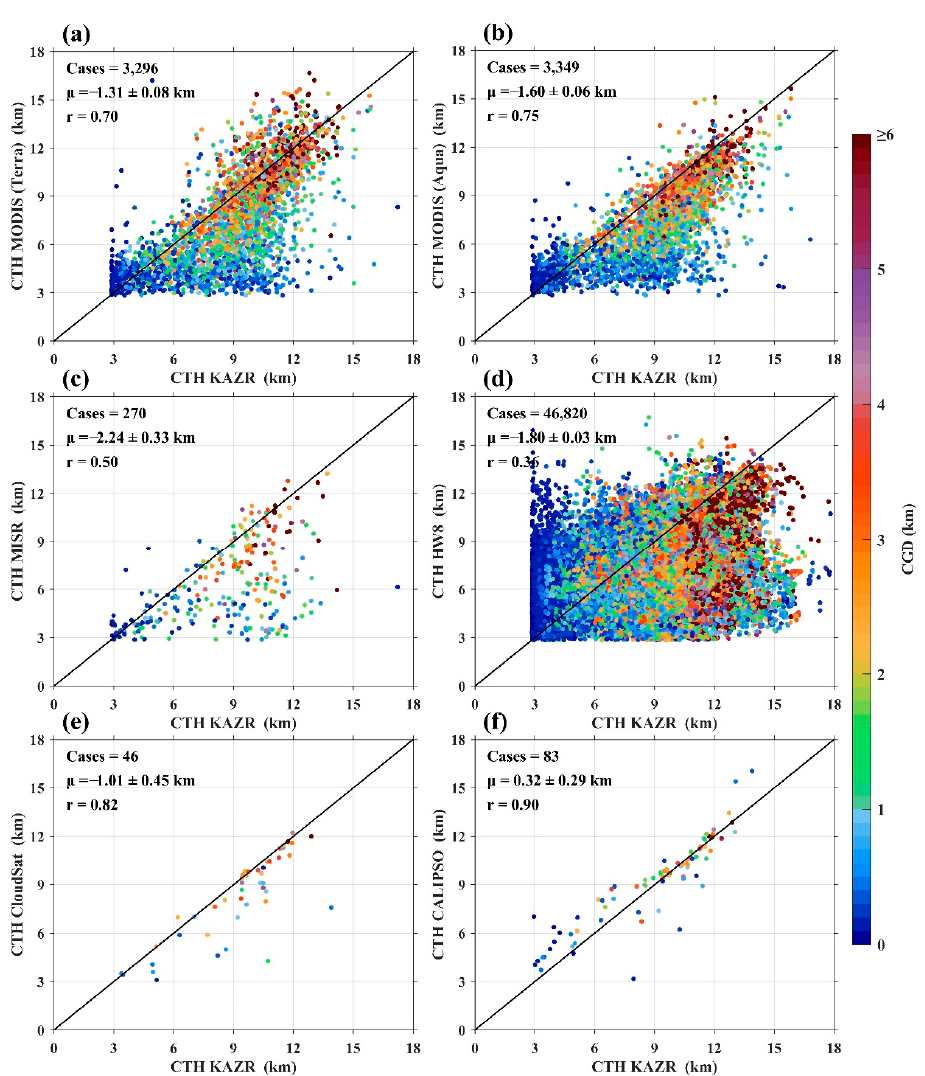
Figure 12. Scatterplots of average cloud-top heights derived from KAZR and satellite observations for all clouds. The colored dots indicate the mean CGD of the upper cloud measured by KAZR. The mark in subplot is same as that in Figure 5 but for all clouds. These subplots are for different satellite-KAZR pairs, ( a ) MODIS(Terra), ( b ) MODIS(Aqua), ( c ) MISR, ( d ) HW8, ( e ) CloudSat, and ( f ) CALIPSO.